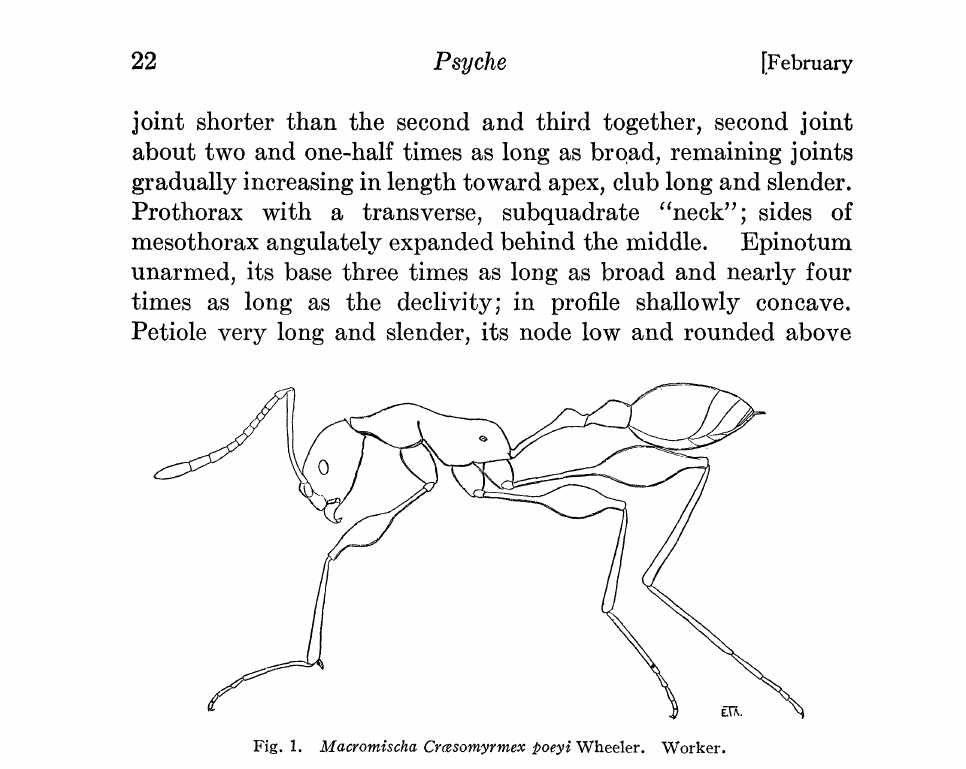
Fig. 1. Macromischa Crcesomyrmex poeyi Wheeler.